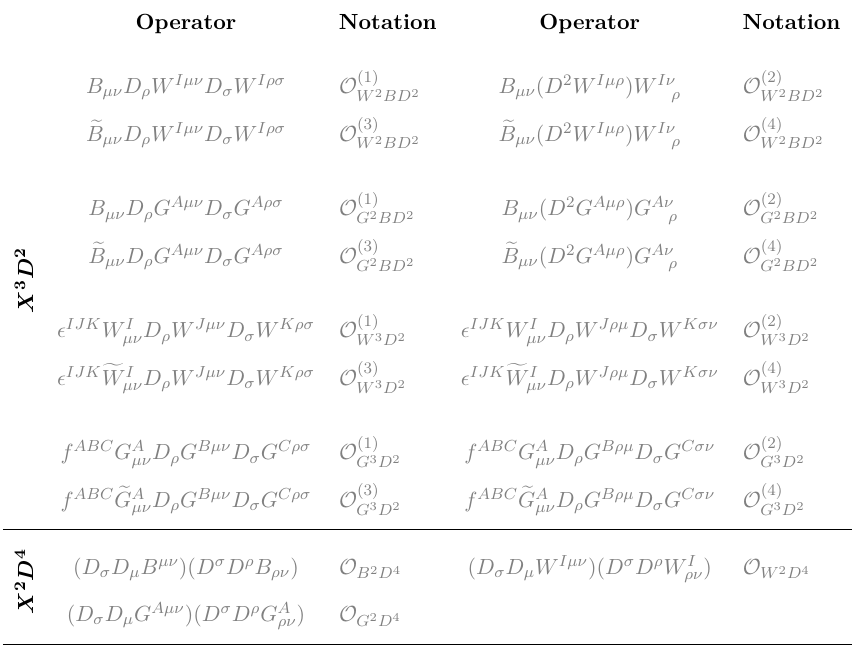
Table 4 . Green’s basis of operators, part